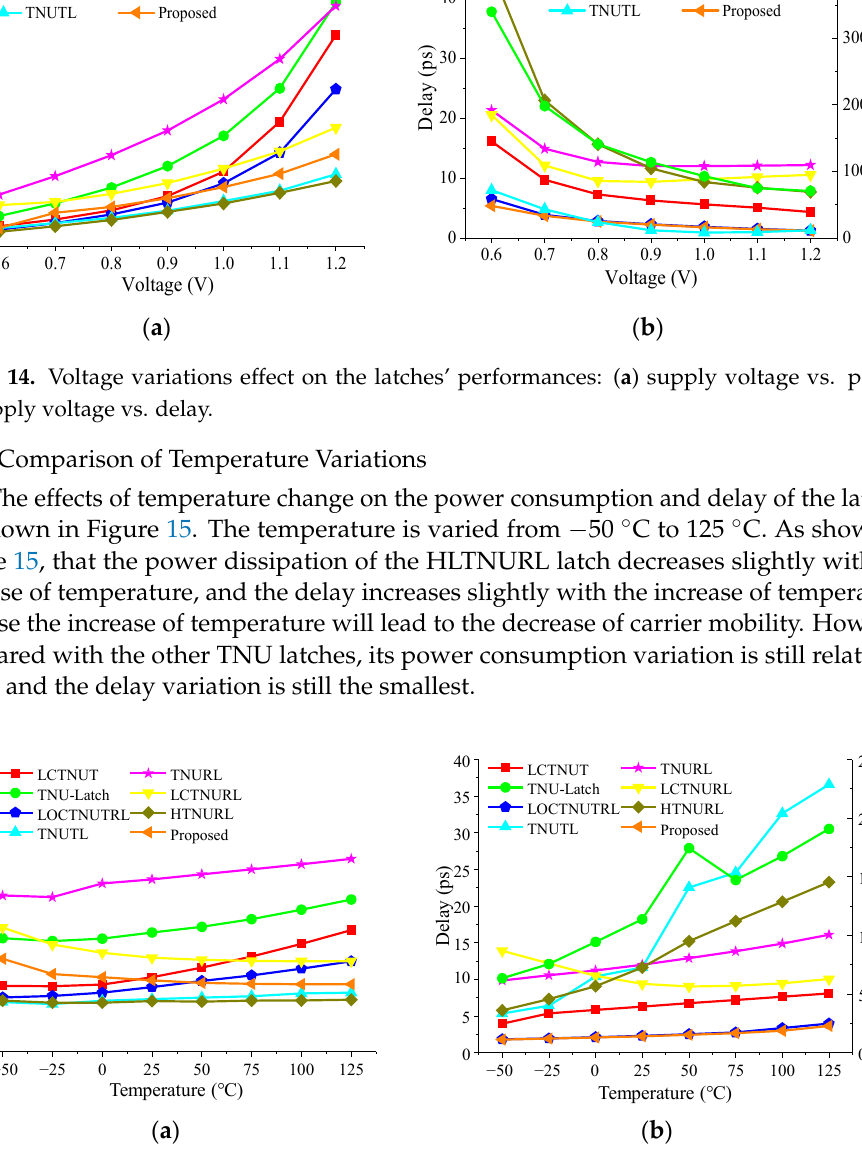
Figure 15. Temperature variations effect on the latches’ performances: ( a ) temperature vs. power; ( b ) temperature vs. delay.